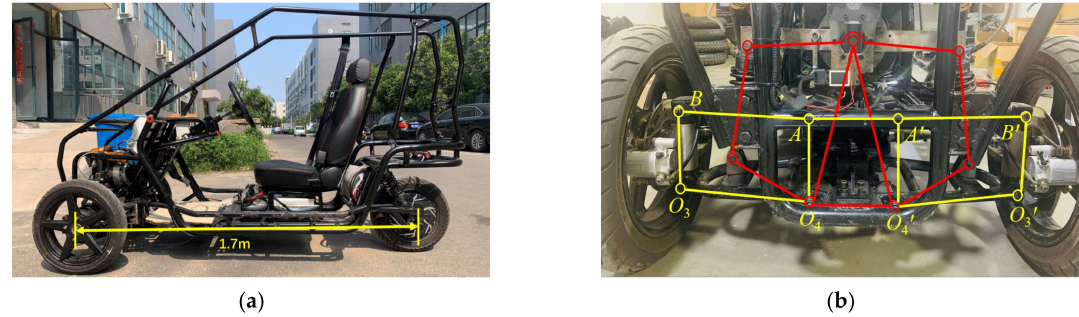
Figure 8. The prototype. ( a ) The prototype; ( b ) The parallel mechanism.